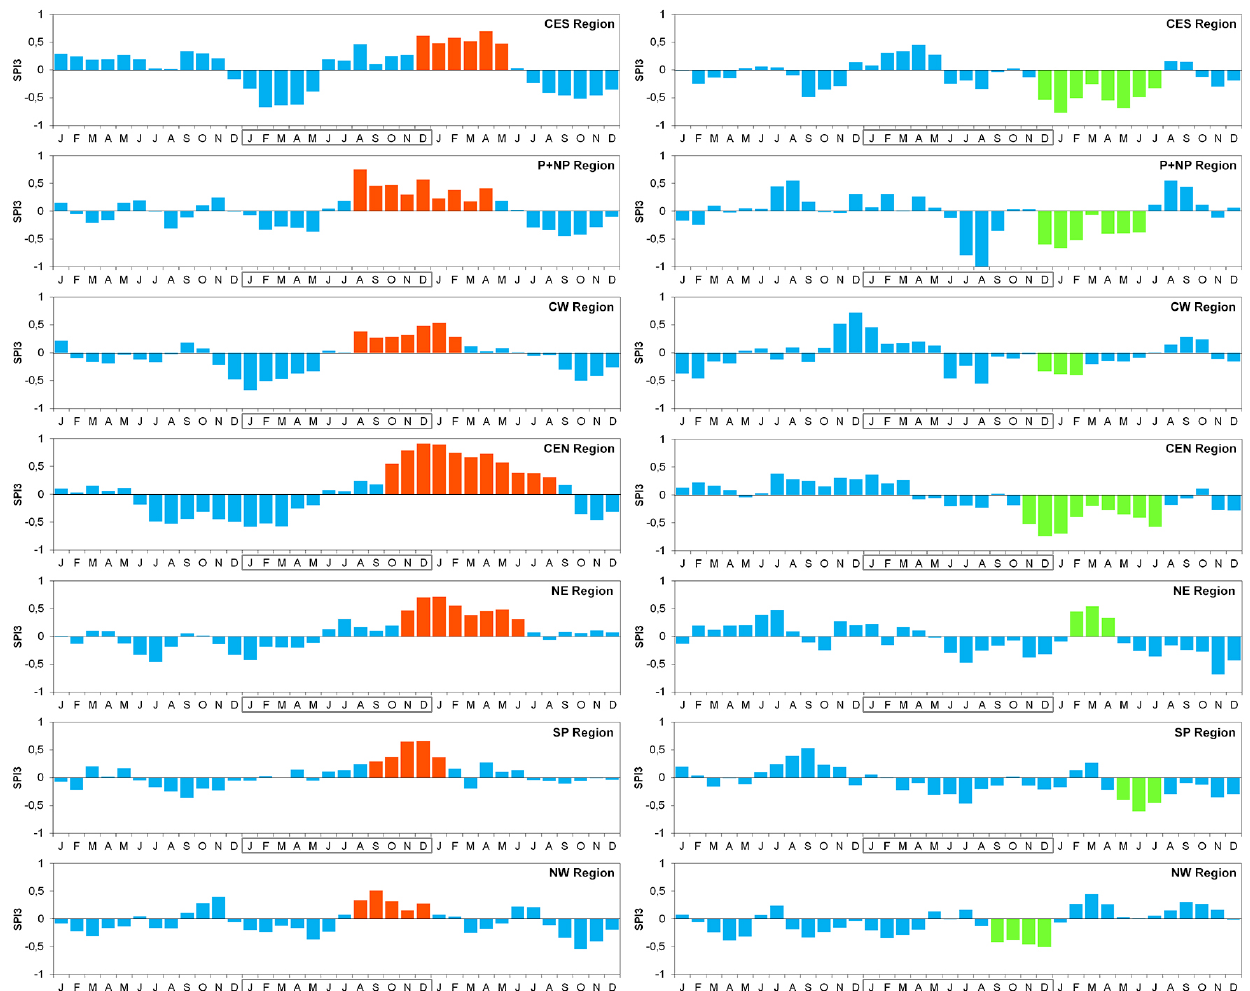
Figure 4. Regional aggregate SPI3 composites during El Niño (left) and La Niña (right) events. The months in the box refer to El Niño or La Niña years (0). Red (green) bars highlight the months of possible El Niño (La Niña) influence on the SPI3 time